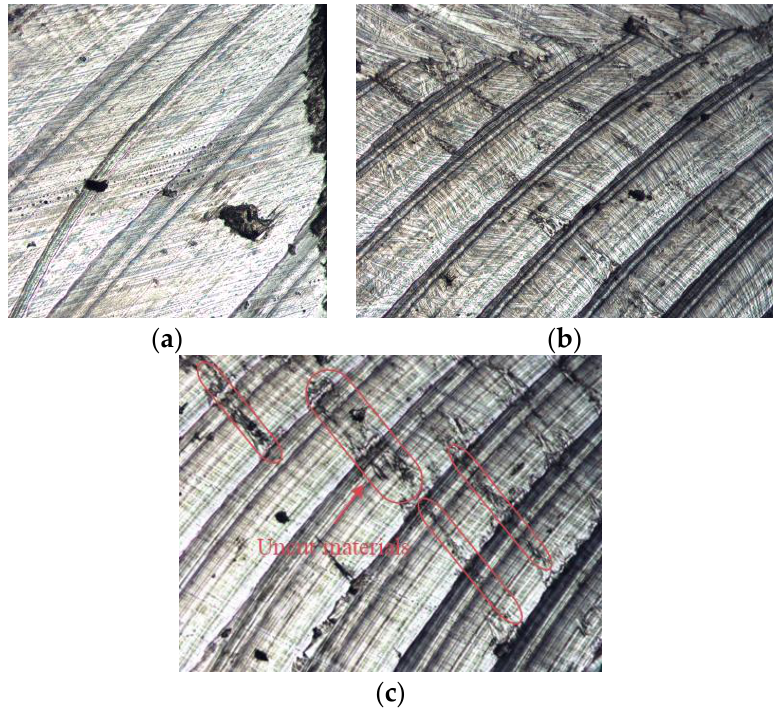
Figure 17. Surface irregularities ( a ) partially defect-free, ( b ) partially pore-free, ( c ) smeared and adhered uncut material that are observed on the machined surfaces of additively manufactured alloy Inconel